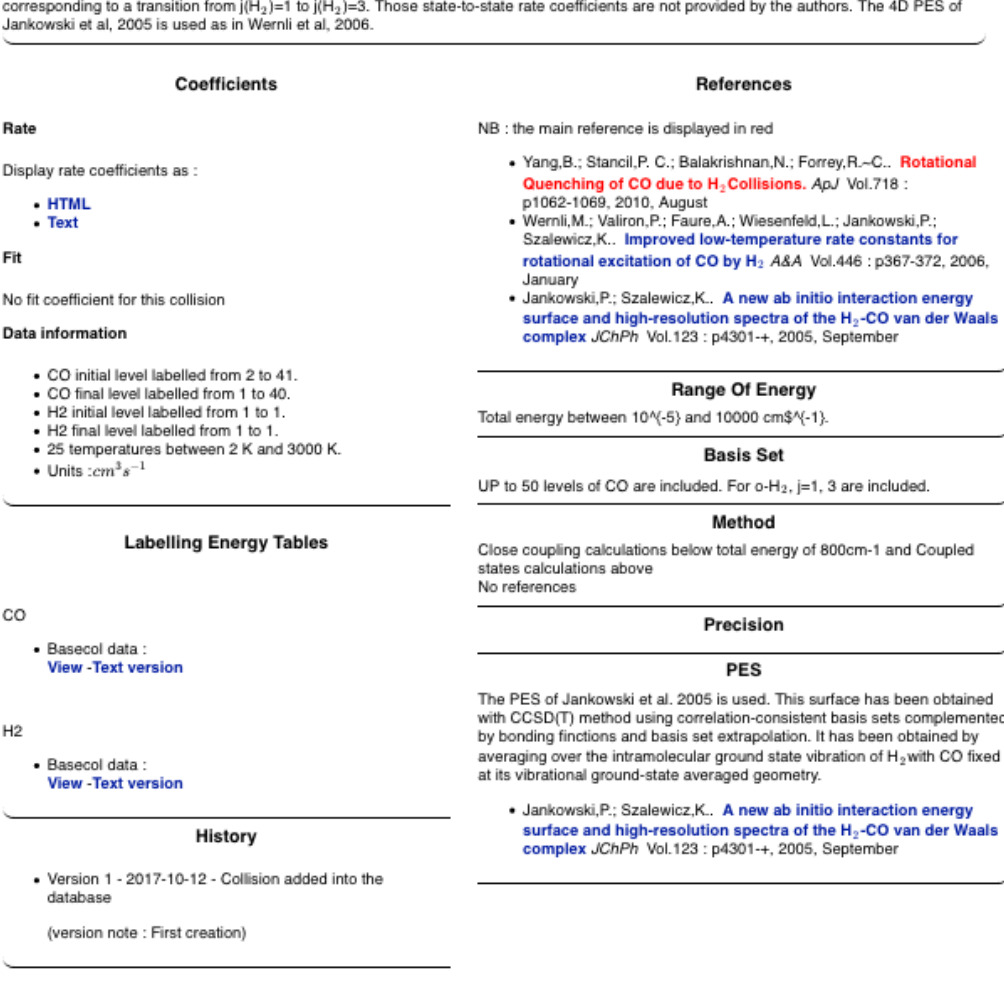
Figure 6. Return page containing the CO–ortho-H 2 data set when the reference of Yang et al. [25] is selected. In a future release we will simplify the interface so that the sections “Range of Energy”, “Basis Set”, “Method” be combined into a single item called